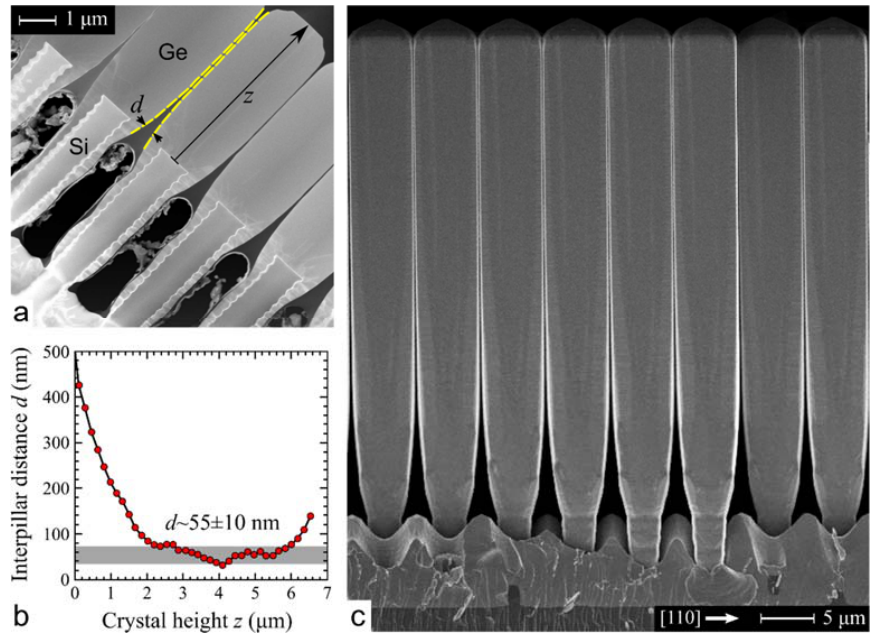
Figure 1. Self-aligned vertical growth of Ge micro-crystals on 2 × 2 μ m 2 Si pillars, 8 μ m deep. ( a ) Dark-field STEM view of 7 μ m tall Ge crystals grown at 440 °C on pillars spaced by 2 μ m. ( b ) Plot of the distance between the adjacent crystals in panel a. ( c ). SEM lateral view of 50 μ m tall Ge crystals grown at 490 °C on pillars spaced by 4 μ m. Reproduced with permission from [12].